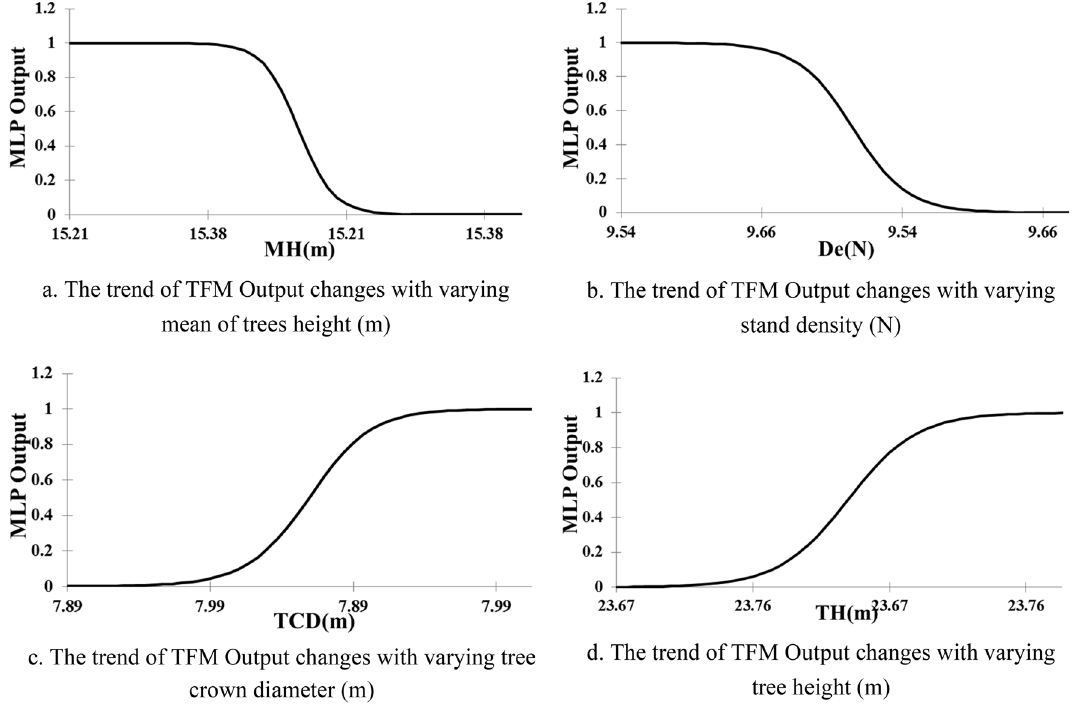
Figure 8. The trend of TFMMLP Output changes with varying the most significant